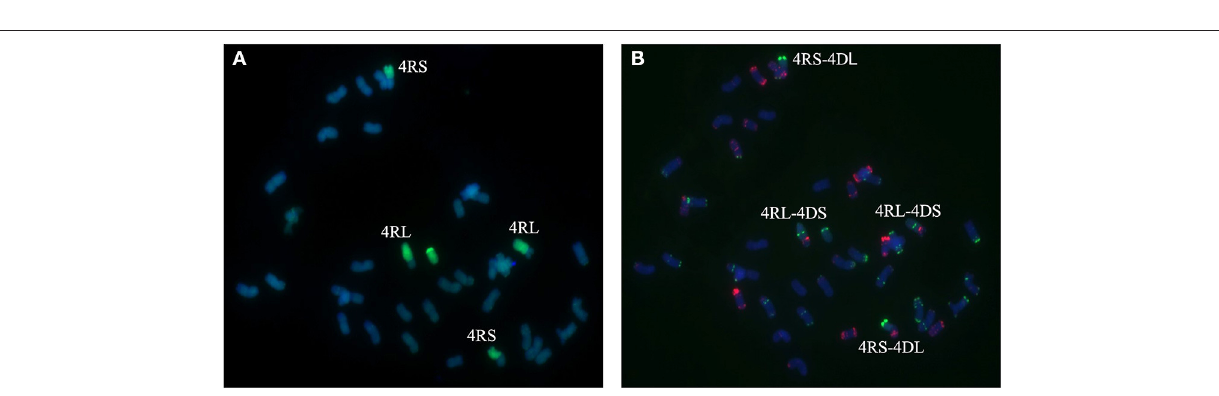
hexaploid triticale cv. Sorento into susceptible wheat line Xuezao by backcrossing. The resulting BC 1 F 1 , BC 2 F 1 , BC 2 F 2, and BC 3 F 1 plants were genotyped with rye chromosome-specific markers and evaluated for resistance against powdery mildew and